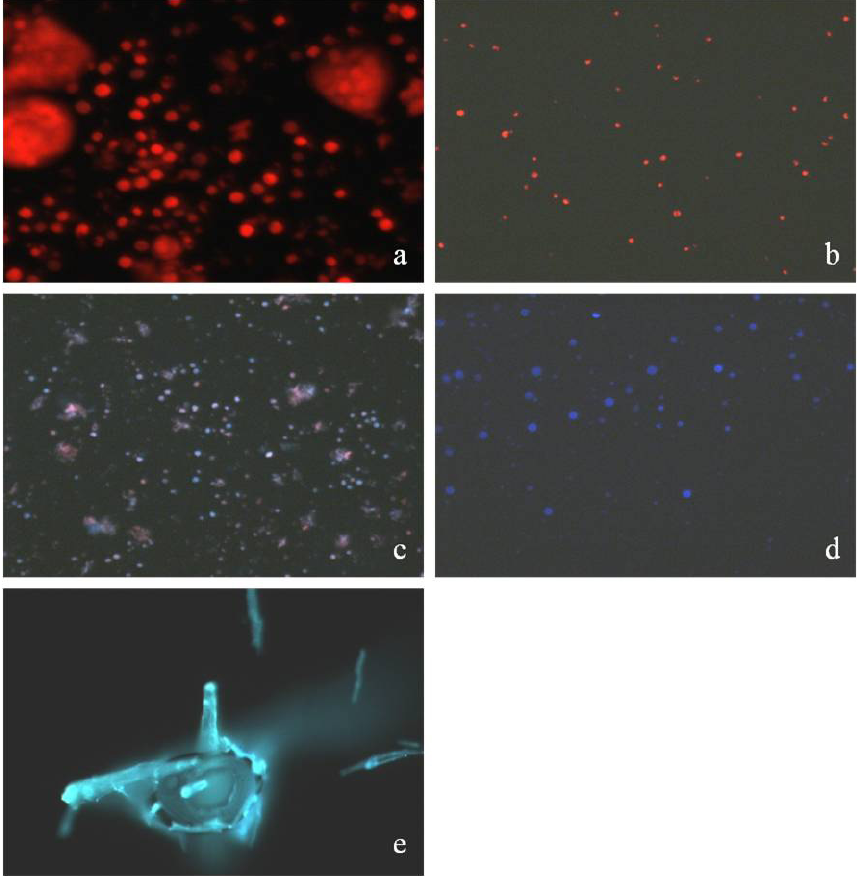
Figure 6. Fluorescence microscope; (a) Start–Dry algae Chlorella kessleri in medium; Red Fluorescence; Resolution 40×10 (filter F1); (b) Start– Live algae Chlorella kessleri in medium; Red Fluorescence; Resolution 40×10 (filter F1); (c) Dry algae Chlorella kessleri + BaP after 144 h; Blue Fluorescence; Resolution 40×10 (filter F1); (d) Live algae Chlorella kessleri + BaP after 144 h; Blue Fluorescence; Resolution 40×10 (filter F1); (e) Pure BaP; Blue Fluorescence; Resolution 40×10 (filter